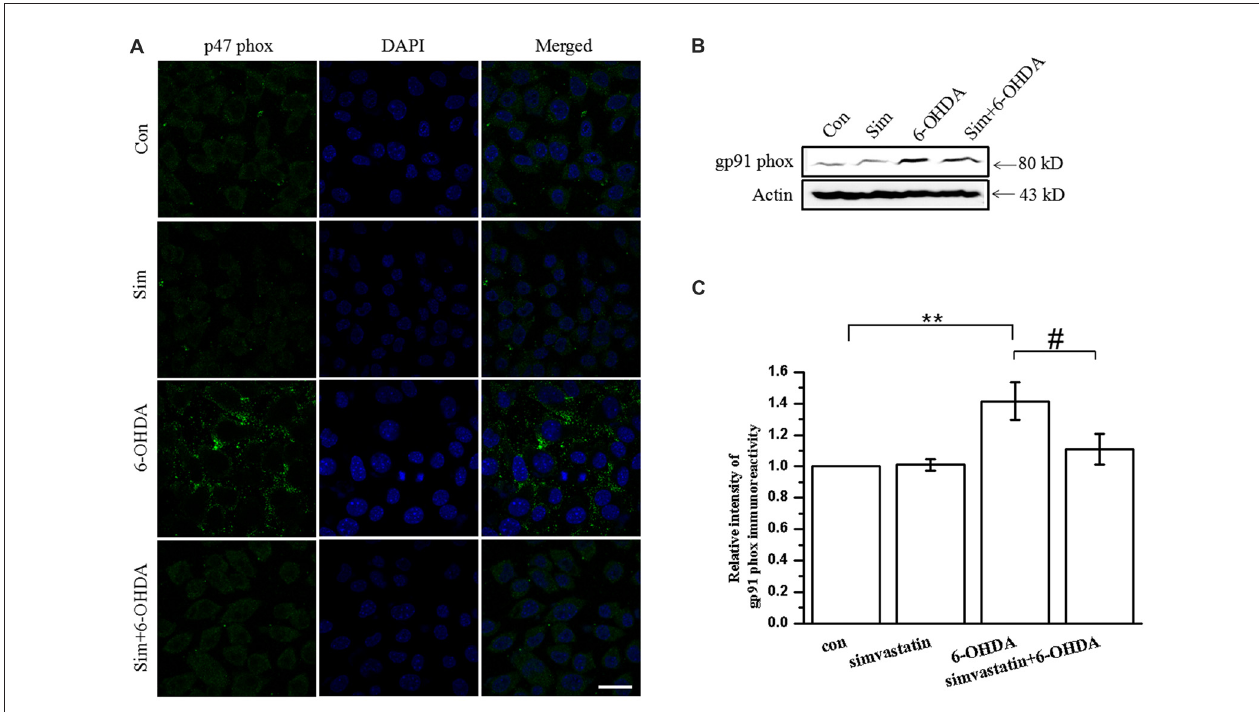
FIGURE 3 | Simvastatin can inhibit 6-OHDA-induced nicotinamide adenine dinucleotide phosphate (NADPH) oxidase activation in SH-SY5Y cells. SH-SY5Y cells were co-treated with 1 µ mol/L simvastatin or 100 µ mol/L 6-OHDA. (A) Cell slides treated for 24 h and photographed after immunofluorescent staining, to detect levels of membrane p47 phox in SH-SY5Y cells. (B) Culture medium was discarded after 12 h treatment, total protein was extracted and total gp91 phox expression detected by western blot. (C) Relative quantitative analysis of gp91 phox expression. Scale bar, 30 µ m. Data were obtained from three independent experiments. Statistical analysis by Dunnett’s T3 or LSD post hoc test based on ANOVA; data expressed as mean ± SEM. ∗∗ P < 0.01, # P < 0.05.